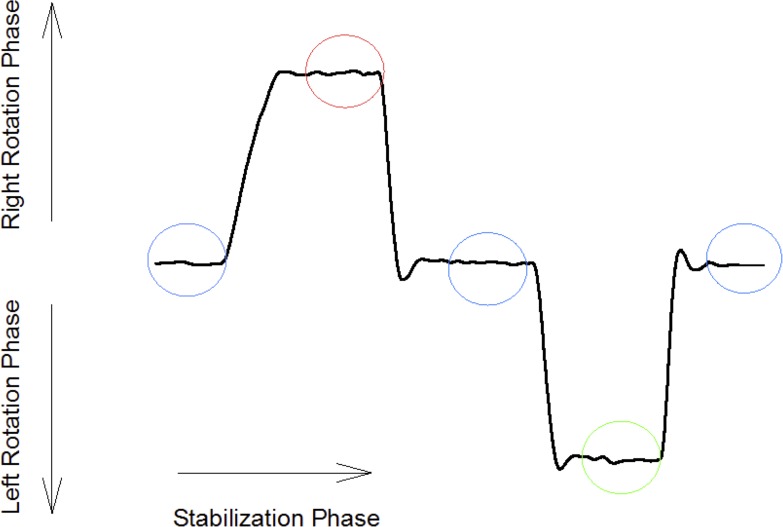
Typical trace recorded during head rotations.Head rotations phases are visualized by the ascendant/descendant phase of the solid line and stabilization phases are visualized by the horizontal phase of the solid line. Blue circles are for center target. Red circle is for right target. Green circle is for left target.